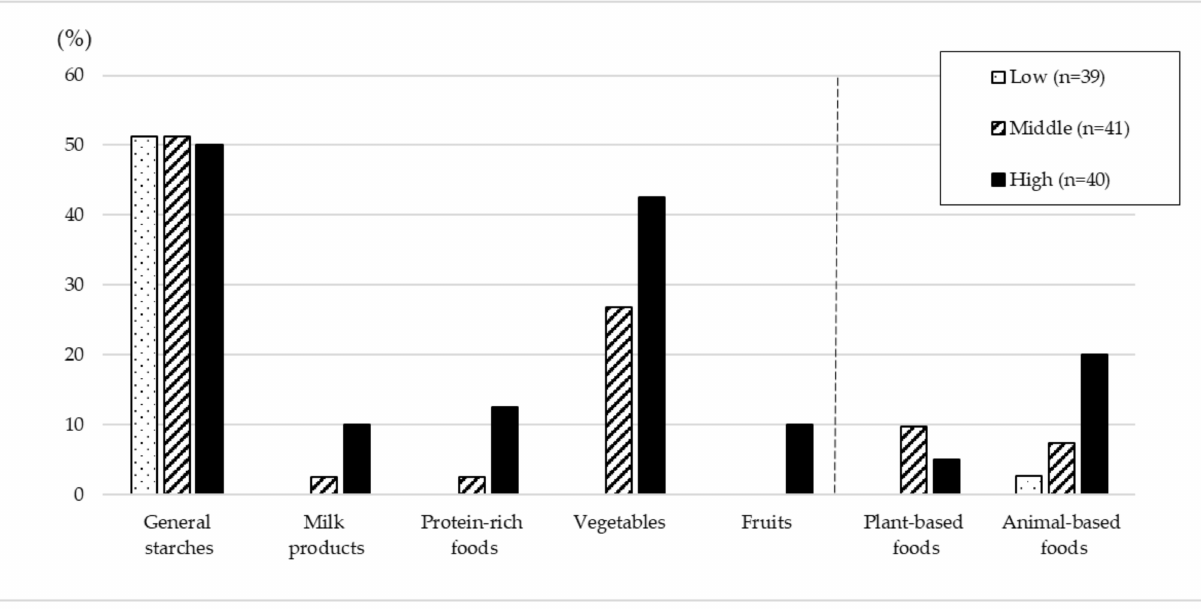
Figure 1. The proportion of those who met the recommendations by FP score* tertiles. * FP score indicates adherence to the recommendations of the Kenyan FP, and was calculated from the individual average dietary intake over two